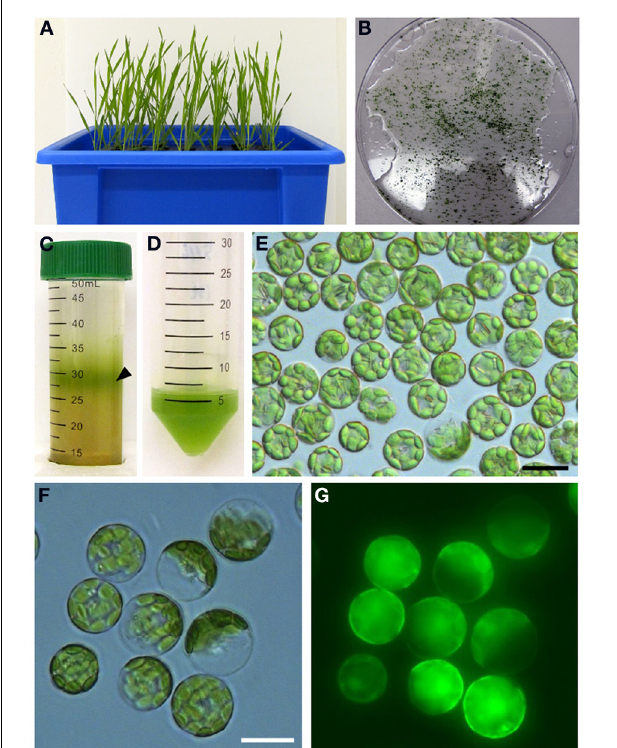
FIGURE 6 | Isolation of protoplasts from brachypodium. Hydroponically grown 25-day-old plants (A) were used for the isolation of protoplasts from leaf tissue. Chopped brachypodium leaves in filter-sterilized TVL solution are shownin (B) .Enzymaticdigestionofthecellwallandfractionationbysucrose density gradient yielded protoplasts at the interface of the enzyme solution andW5solution( C ,blackarrow).Protoplastswerecollectedandpurifiedfrom sucrose density gradient solution (D) and visualized under microscopy using bright-field filter sets (E) . In our method, 0.2g of leaf tissue from 25-day-old seedlings yields 5 × 10 6 –10 7 protoplasts. Close-up of brachypodium protoplaststhroughbright-field (F) andFITC (G) filtersetstoassessprotoplast viability after staining with the membrane-permeable non-fluorescent dye, fluorescein diacetate. After diffusion into viable protoplasts fluorescein diacetate is hydrolyzed into a polar compound, causing the cytosoplasm of the cell to fluoresce under the FITC filter set. Scale bar = 20 μ